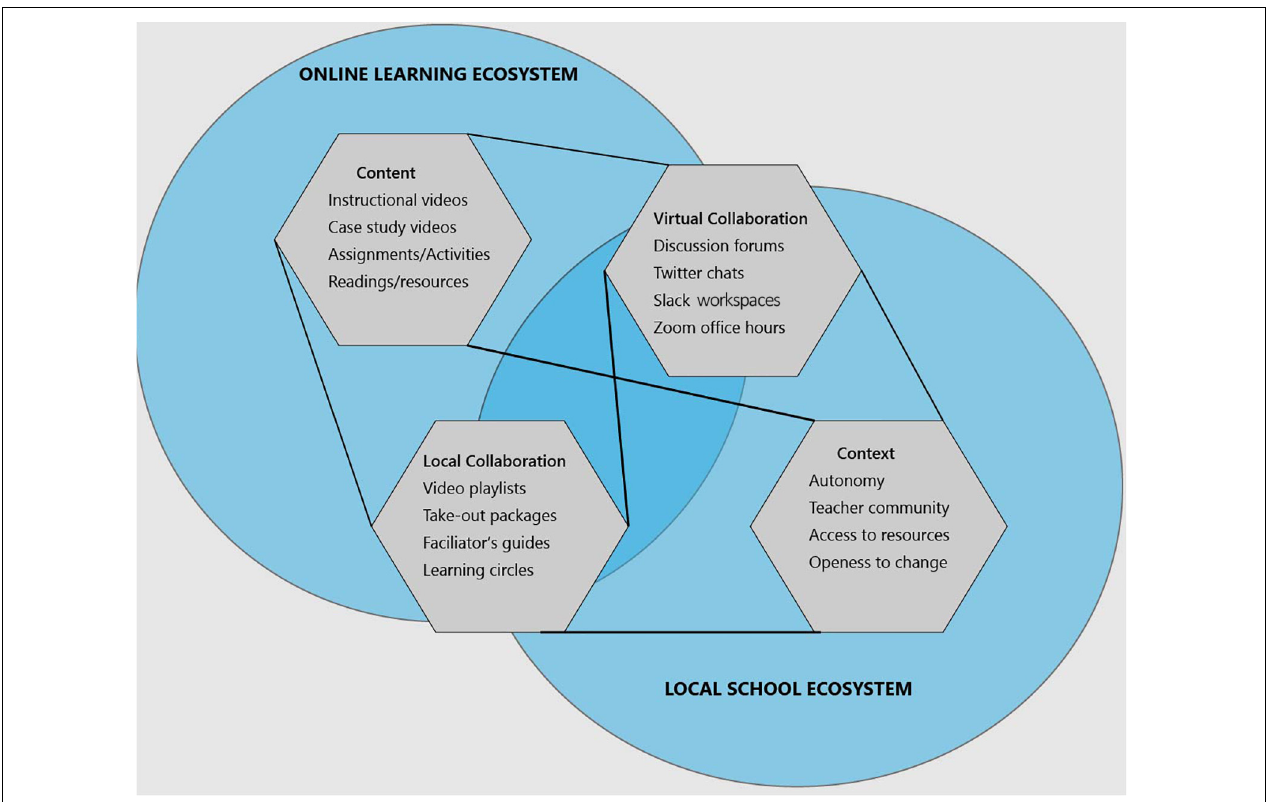
FIGURE 1 | Conceptual model for educator learning in